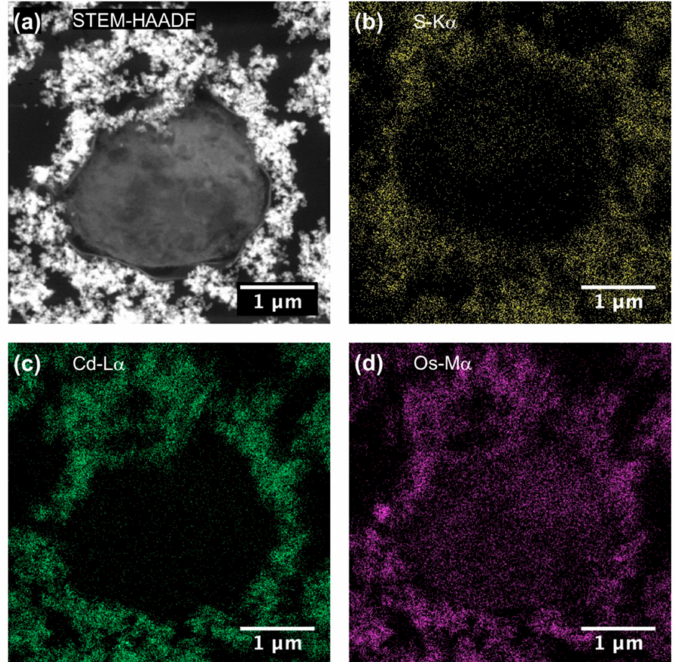
Figure 12. ( a ) STEM-HAADF and ( b – d ) STEM-XEDS images of Chlorella vulgaris ultrastructure after contact with CdS–1 nanoparticles (10 –2 M) in Seine river.